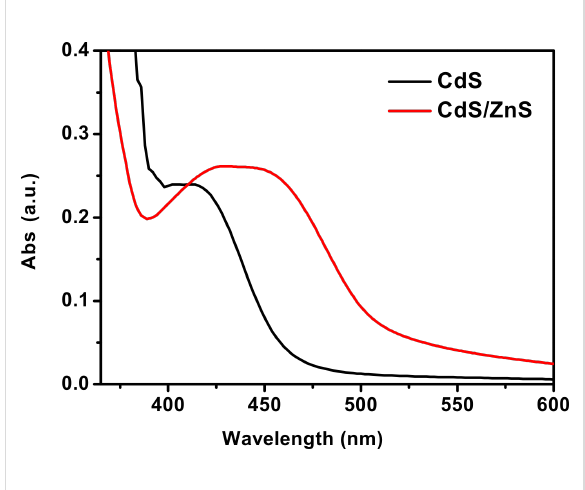
Figure 2: Absorption spectra for CdS and CdS/ZnS